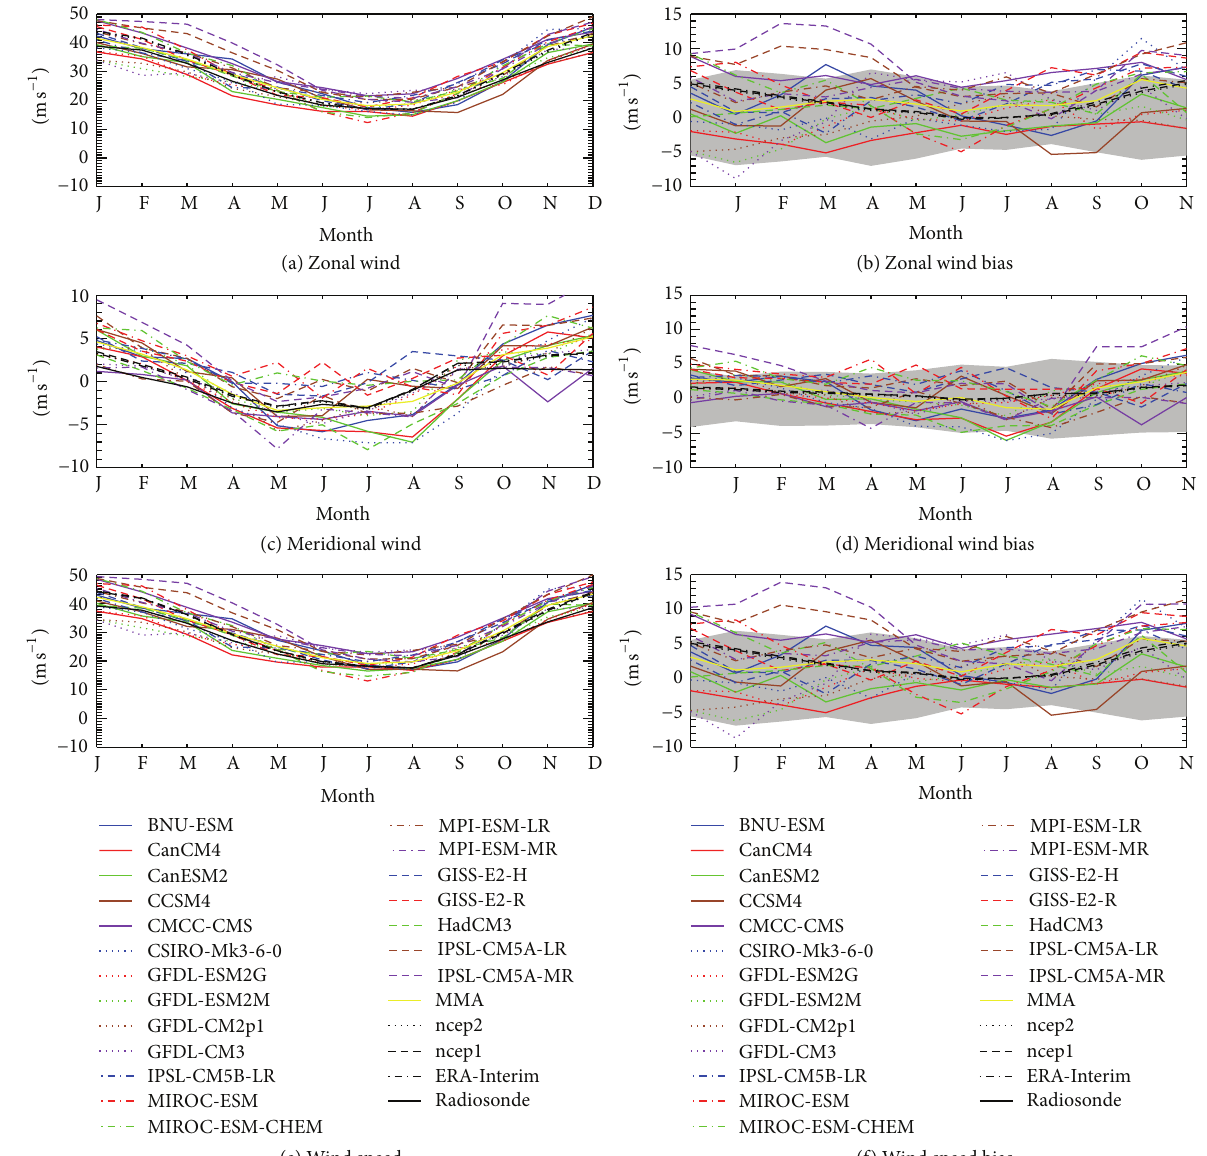
Figure 5: Sterling station seasonal cycle at 200 hPa from individual CMIP5, reanalysis, and radiosonde observation for 1979–2005. The gray shading in (b), (d), and (f) is the radiosonde plus and minus 1 standard deviation around the climatology mean.